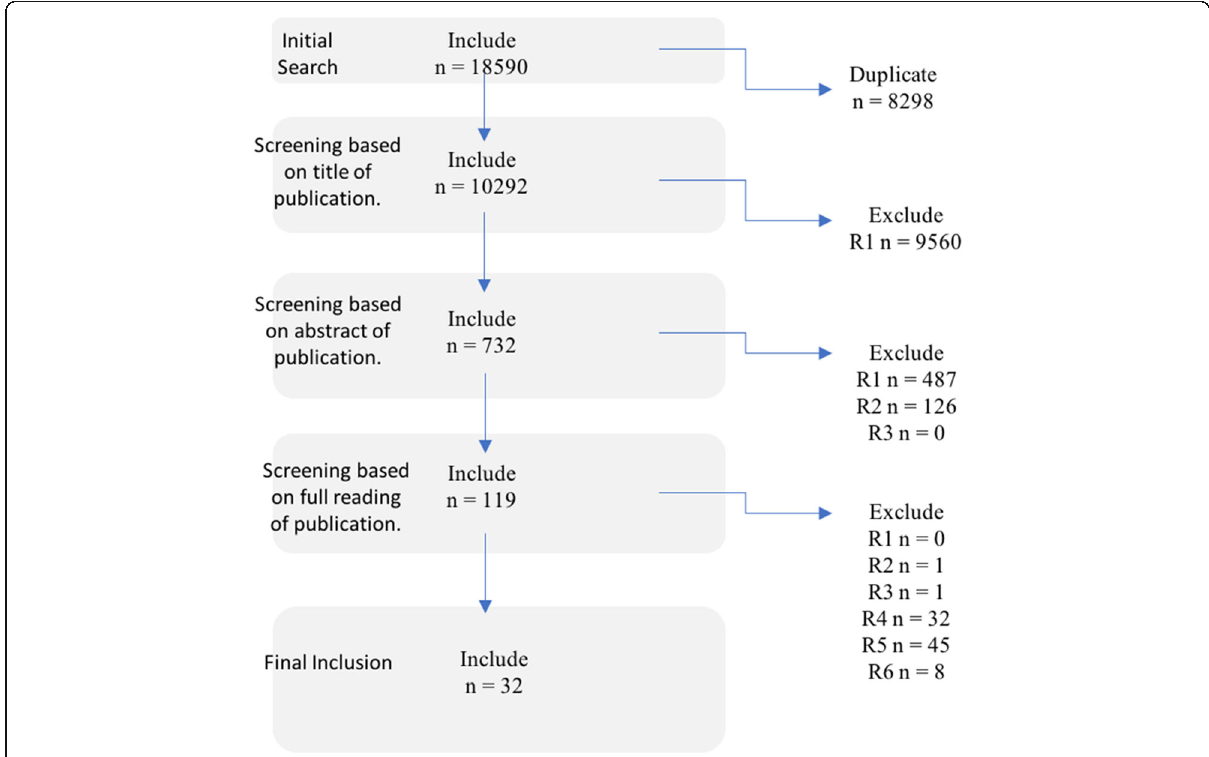
Fig. 1 Flowchart of literature search and exclusion. Note:R1 not relevant to the topic, R2 not primary, peer reviewed source, R3 not in English, R4 no objective marker of exercise, R5 no measure of CAR, R6